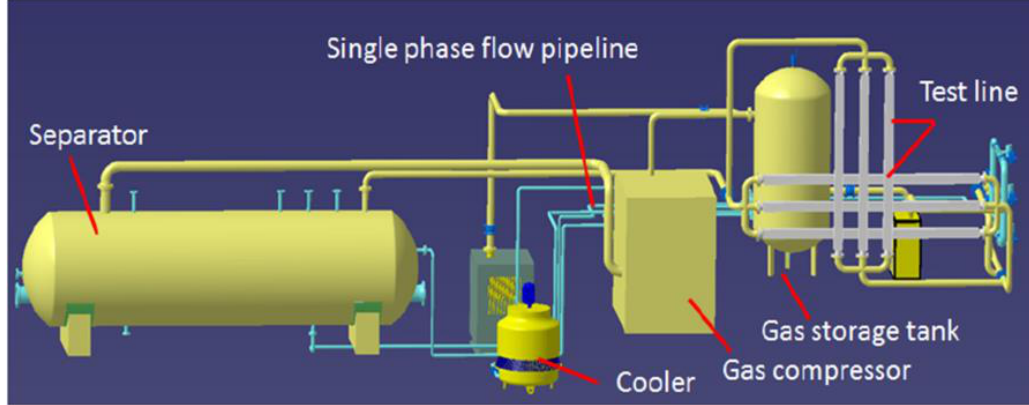
Figure 2. Schematic diagram of experimental equipment.